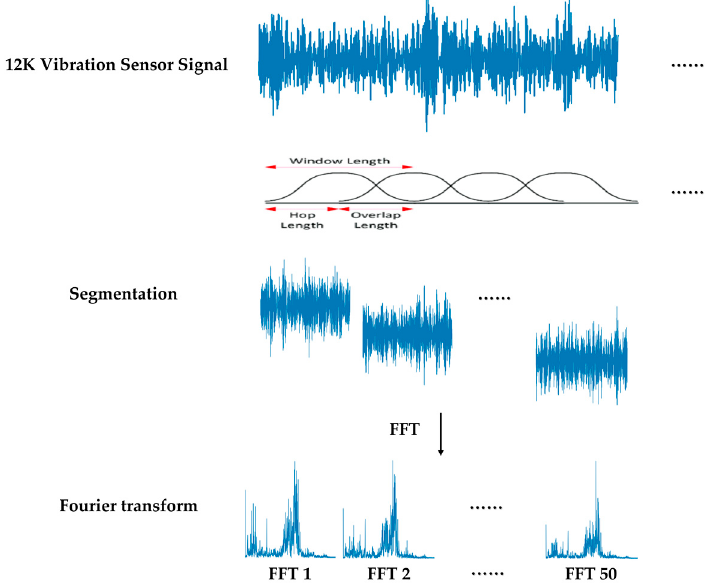
Figure 5. STFT process for generating spectrogram from vibration sensor signal [24].